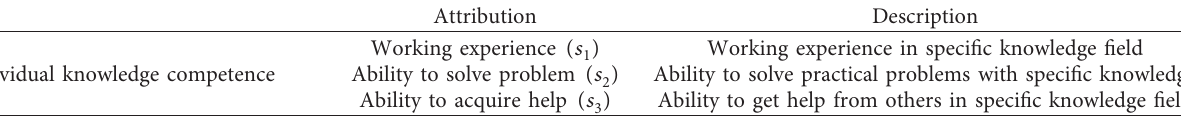
Table 2: Indicators for member selection of CPIN team.